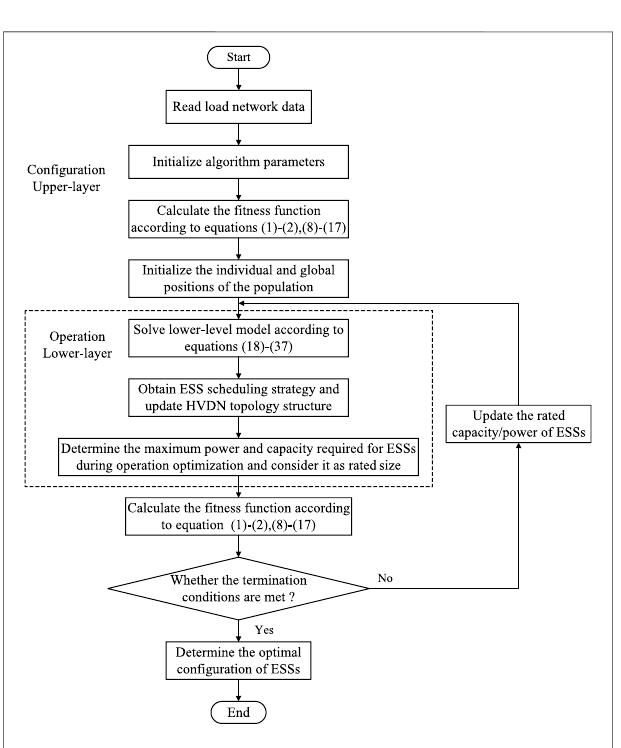
FIGURE 5 | Flowchart of bilevel optimization solution.